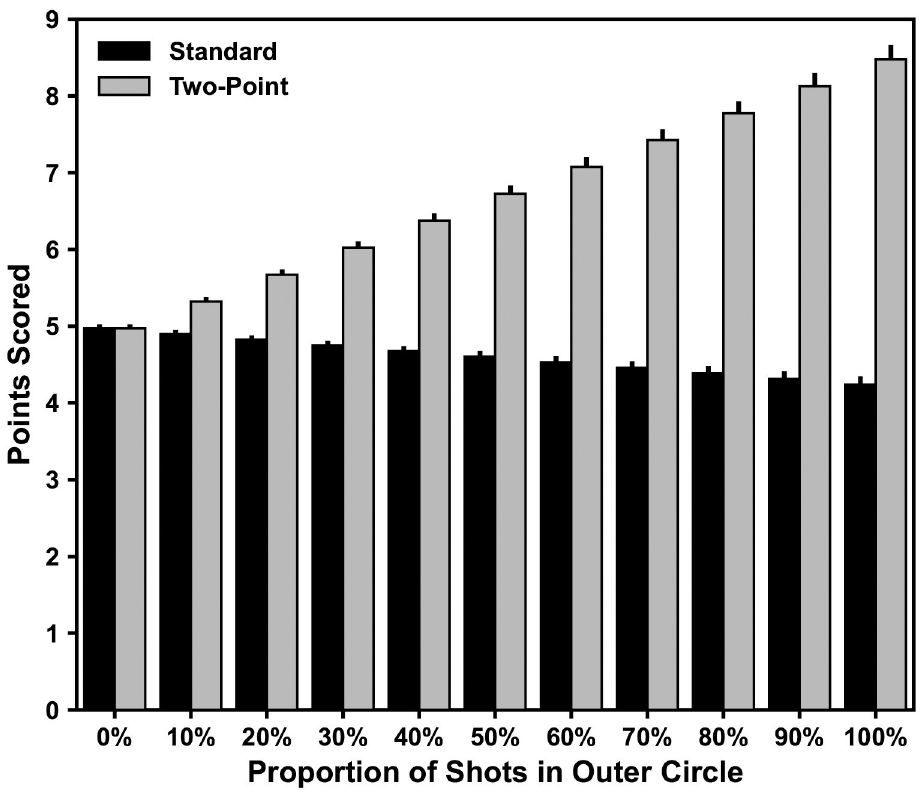
Fig 2. Simulated number of points scored with different shooting proportions from the ‘outer circle’ during a typical five-minute period with standard (i.e. one-point for all shots) versus the two-point (i.e. two-points from the outer circle) rule